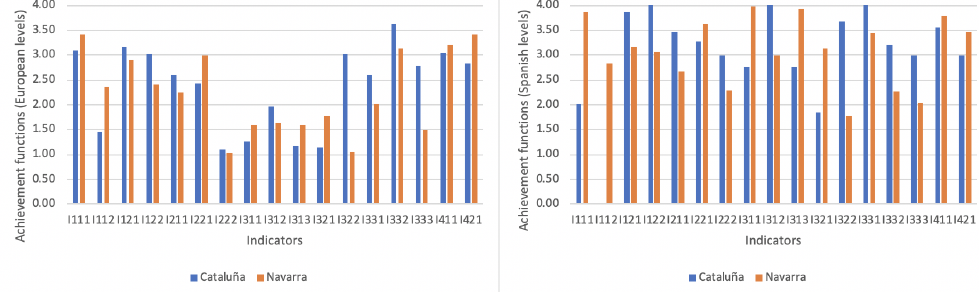
Figure 11. Achievement functions of the single indicators with European levels (left) and Spanish levels (right) for (ES51) Cataluña and (ES22) Comunidad Foral de